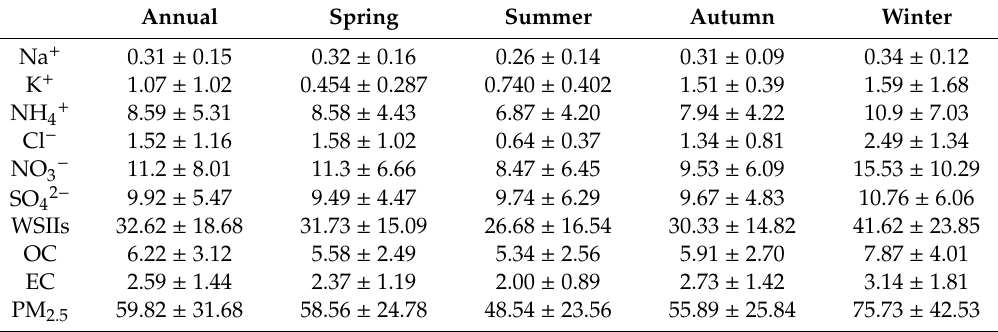
Table 1. Concentrations of fine particulate matter (PM 2.5 ) and its major chemical compositions (mean concentrations ± standard deviation (SD)) for four seasons ( µ g · m − 3